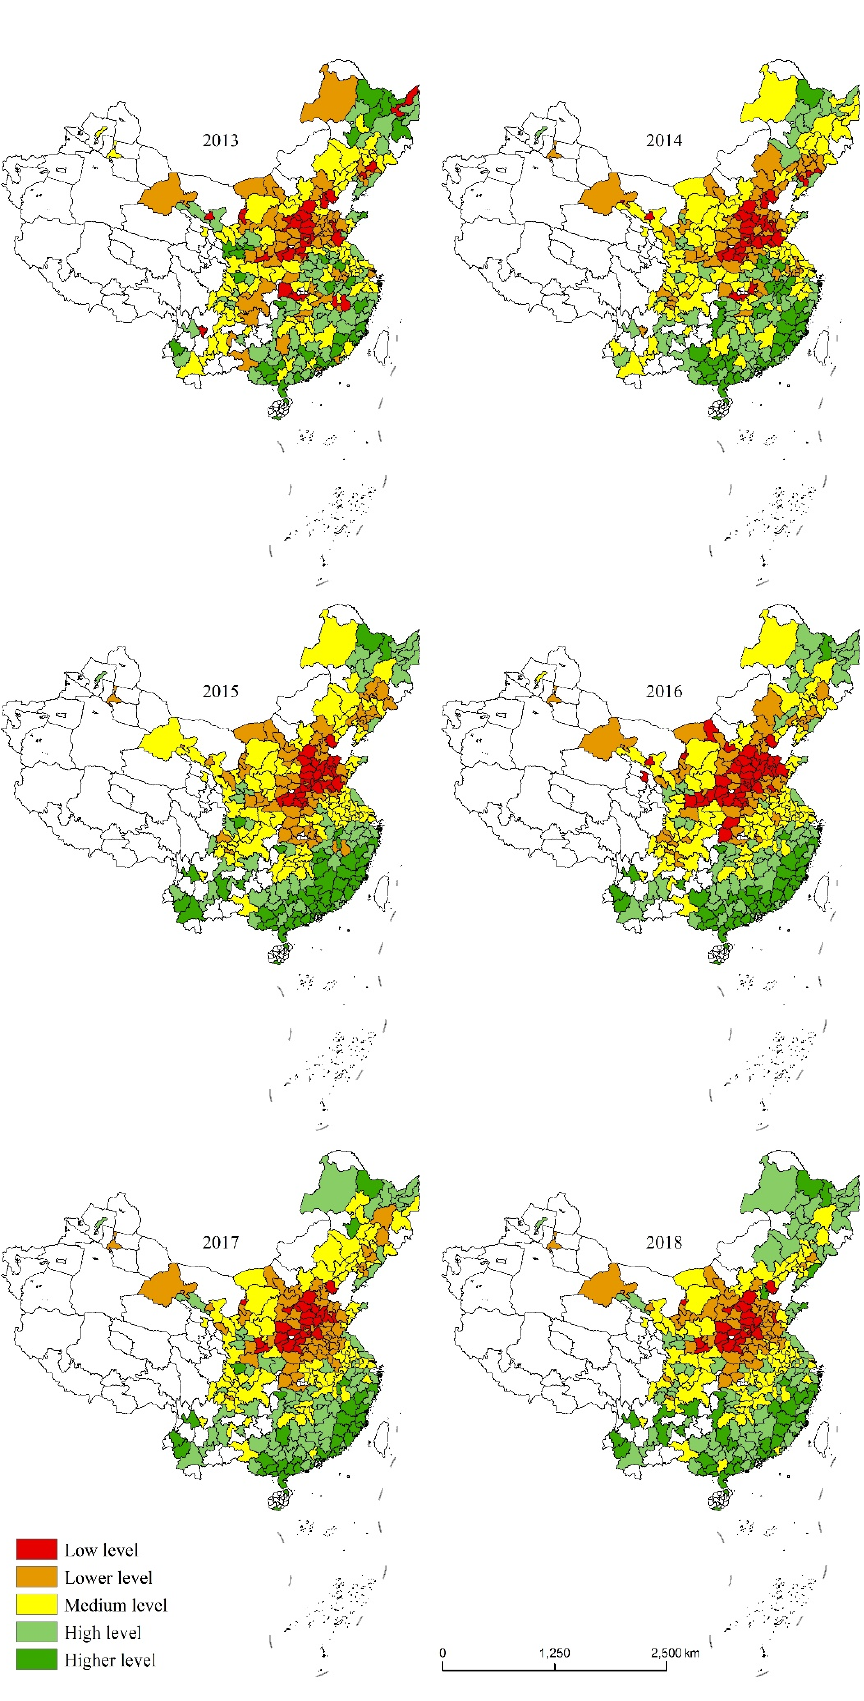
Figure 3. Spatial-temporal evolution for comprehensive scores of human settlements in China’s prefecture-level cities.